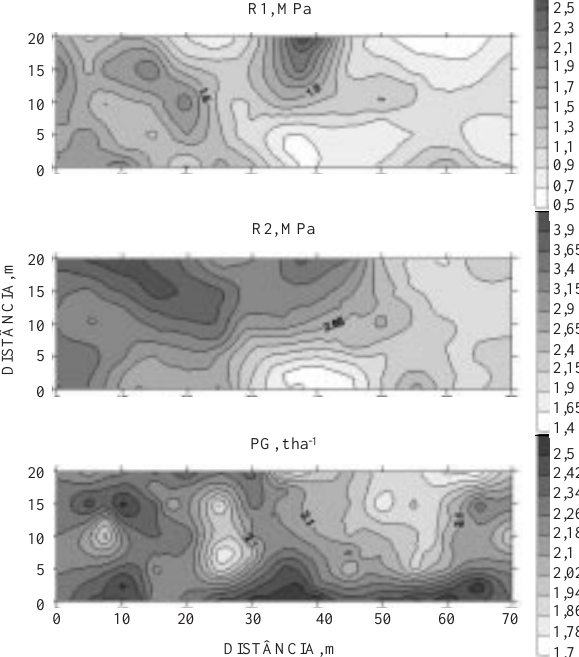
Figura 2. Mapas de krigagem da resistência mecânica à penetração, nas profundidades de 0–0,10 m (R1) e 0,10–0,20 m (R2) de um Latossolo Vermelho distrófico de Selvíria (MS), e do rendimento de grãos do feijoeiro